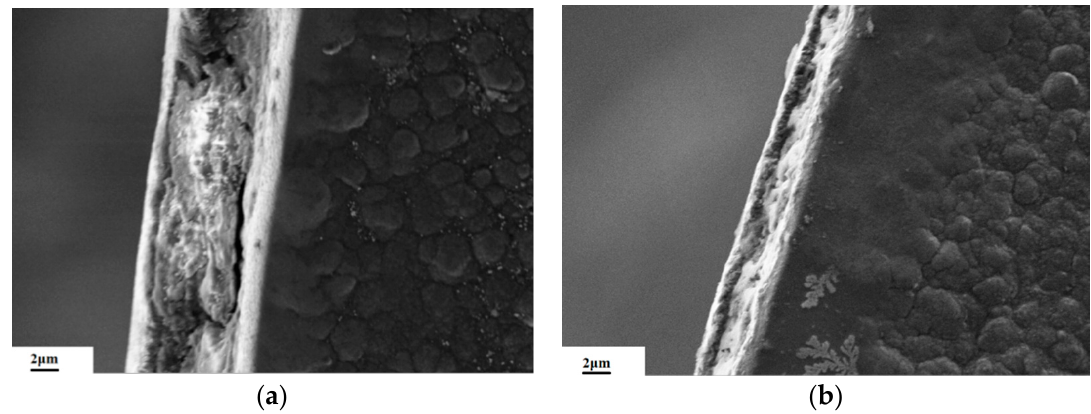
Figure 9. Worn morphology of cutting edge for NCD coated tools. ( a ) n = 4000 rpm, f = 0.004 mm/r; ( b ) n = 6000 rpm, f = 0.008 mm/r.